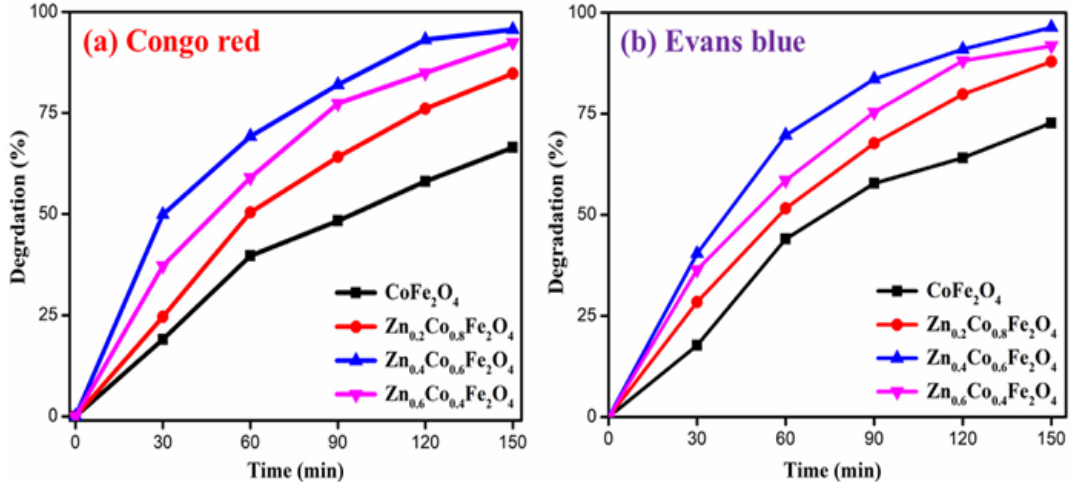
Figure 15. Photocatalytic results of: ( a ) Congo Red (CR) and ( b ) Evans Blue (EB) dyes using zinc-doped cobalt nanoparticles [119]. Republished with permission from Elsevier.